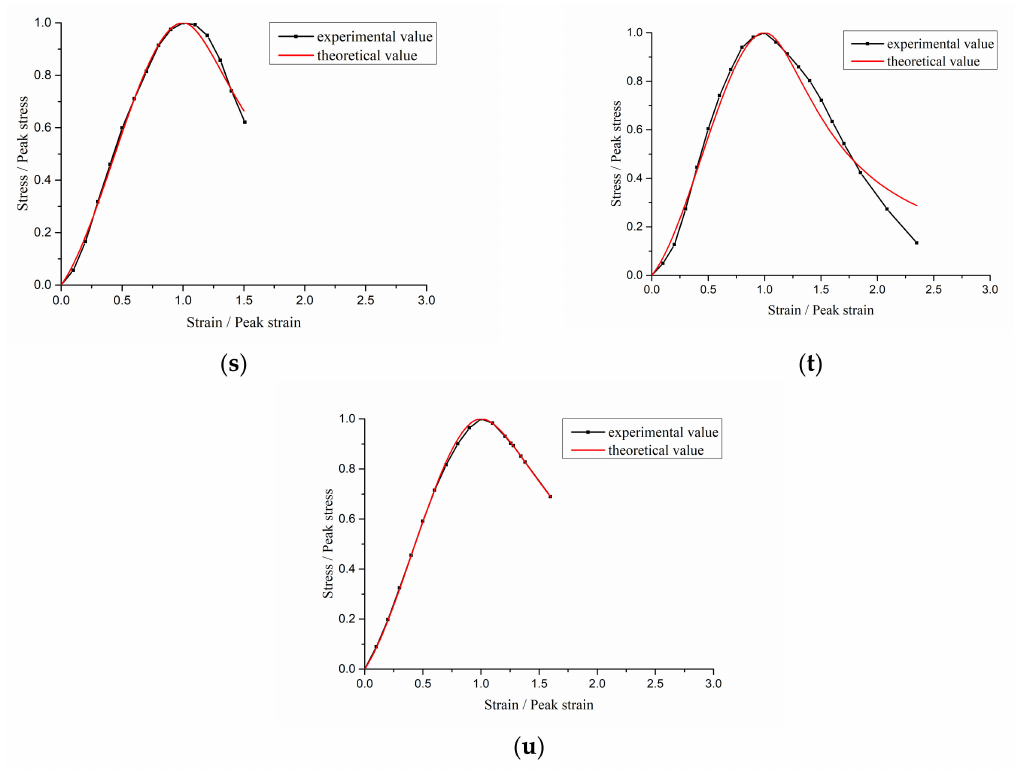
Figure 13. The fitting results of stress–strain relation. ( a ) NAC-0.0 mm; ( b ) NAC-4.9 mm; ( c ) NAC- 9.0 mm; ( d ) NAC-12.2 mm; ( e ) NAC-14.5 mm; ( f ) NAC-17.5 mm; ( g ) NAC-19.8 mm; ( h )